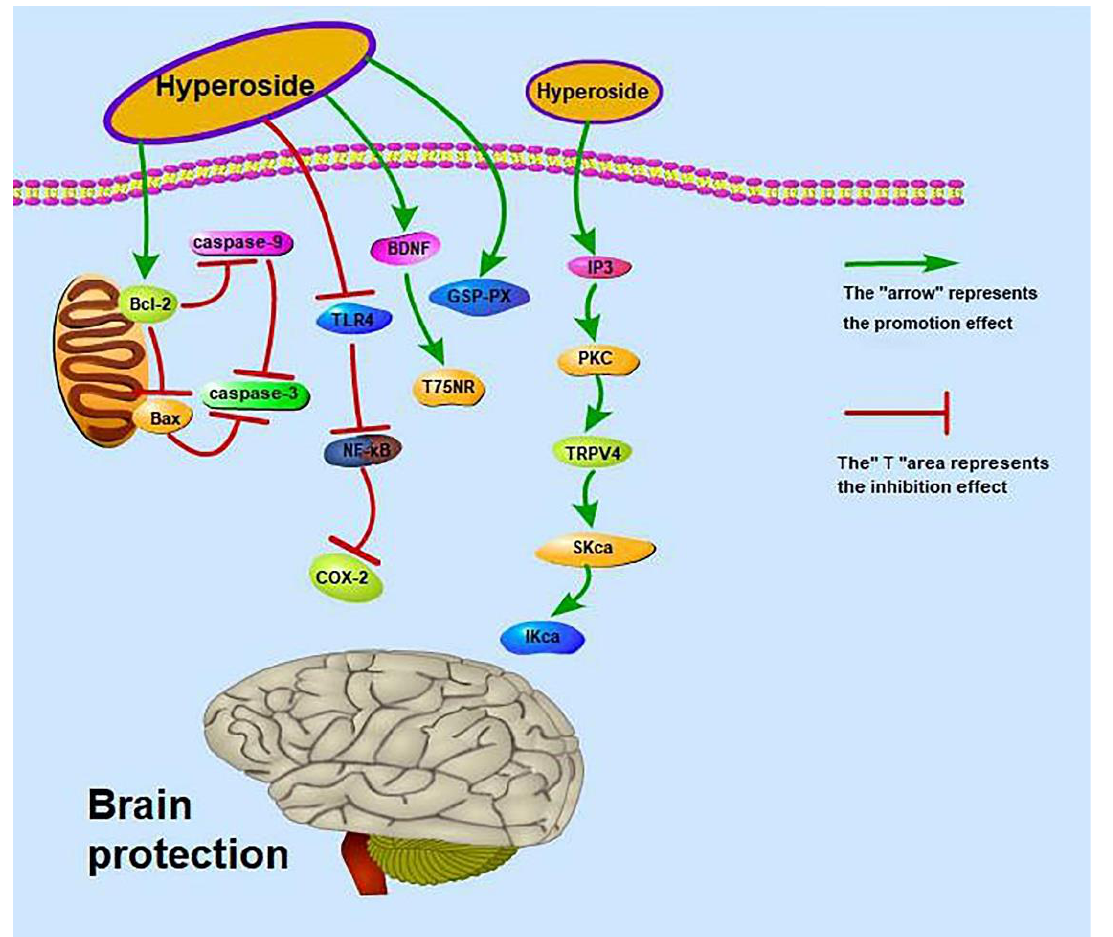
Figure 3. Brain-protective effect of hyperoside.